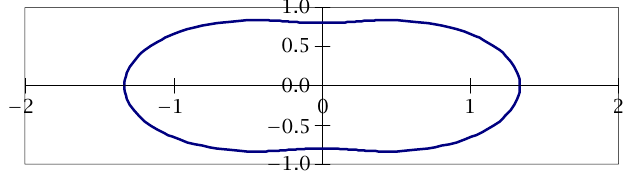
Figure 5.1 . The domain G